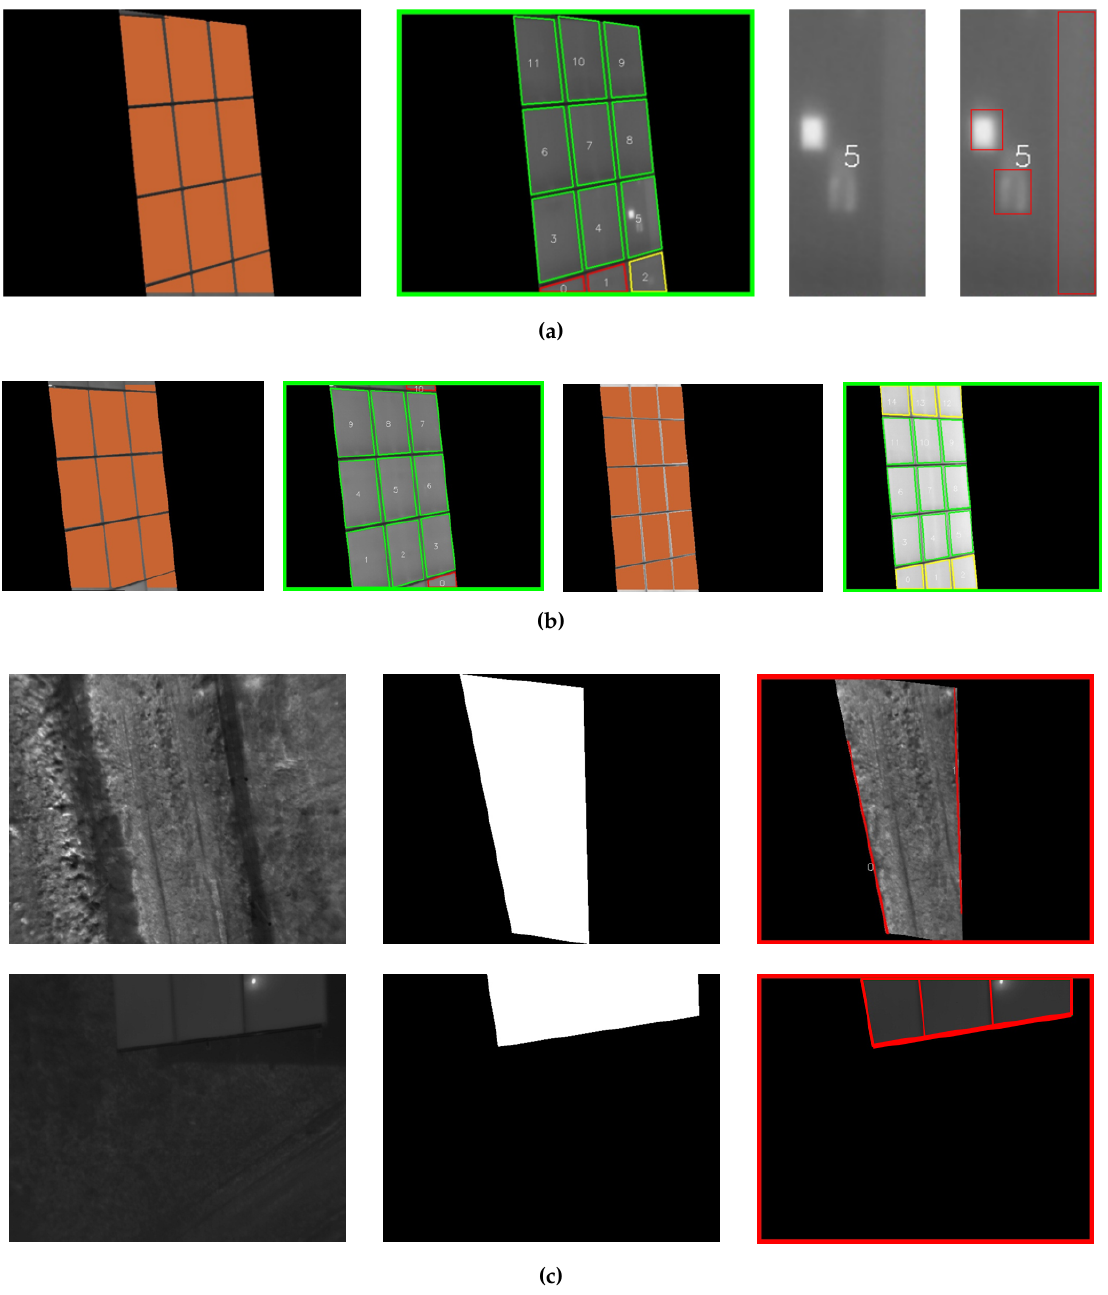
Figure 14. Results of the fault detection procedure. ( a ) Detection of the thermal defects, ( b ) Images without thermal defects. ( c ) Images with high error when correcting the